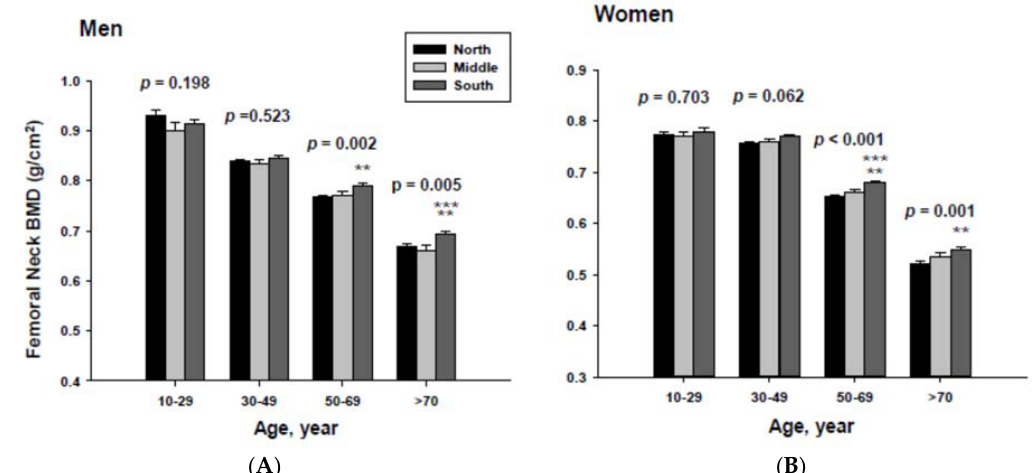
Figure 3. Adjusted mean femoral neck bone mineral densities according to age and geographic location in men ( A ) and women ( B ). The p values are p for trend in the same group from ANCOVA test adjusted for total body fat, smoking, job, alcohol intake, moderate activity and education for men, and for total body fat, smoking, job, alcohol intake, moderate activity, education, menopause, oral contraceptive use and hormone replacement therapy for women. Subject numbers for men are 10–29 years old, 832, 151, 591; 30–49 years old, 1296, 267, 985; 50–69 years old, 976, 286, 902; ≥ 70 years old, 325, 120, 333 for North, Middle and South, respectively, and for women are 10–29 years old, 806, 192, 556; 30–49 years old, 1358, 255, 1017; 50–69 years old, 714, 248, 785; ≥ 70 years old, 304, 131, 413 for North, Middle and South, respectively.** p < 0.05, North vs. South; *** p < 0.05 Middle vs. South.